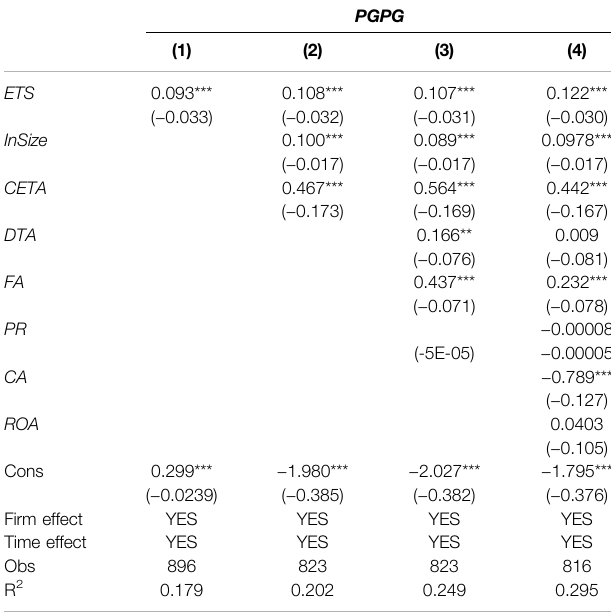
TABLE 3 | The regression results of the proportion of clean energy power